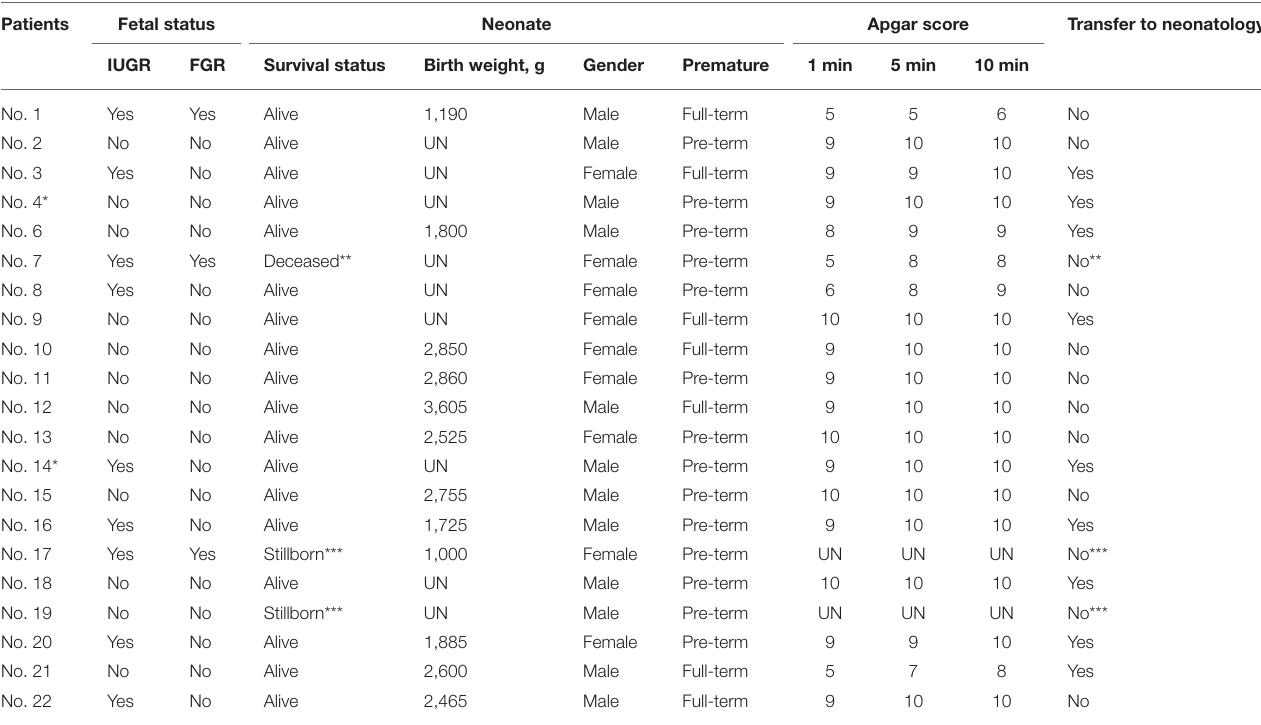
TABLE 5 | Status of the fetus and the newborn after delivery. Patients Fetal status Neonate Apgar score Transfer to